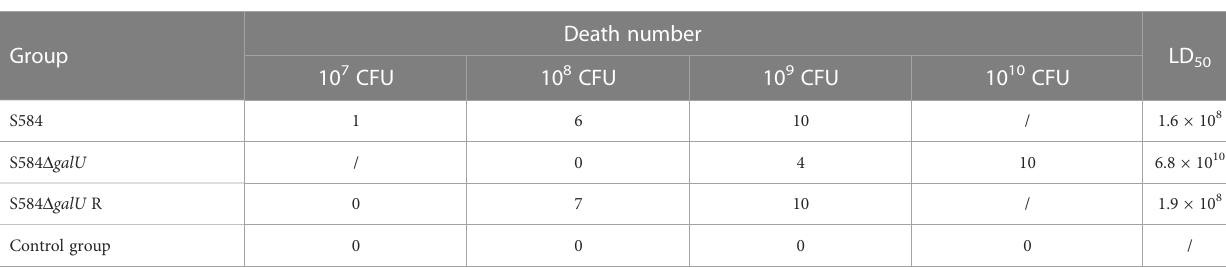
TABLE 2 Virulence analysis of three strains in BALB/c mice.